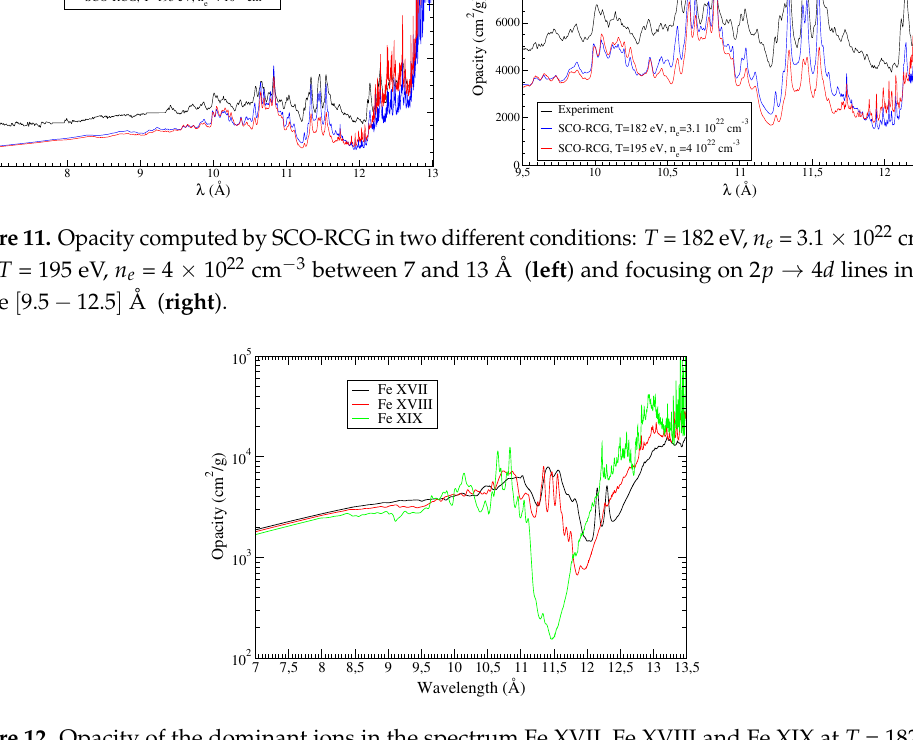
Figure 12. Opacity of the dominant ions in the spectrum Fe XVII, Fe XVIII and Fe XIX at T = 182 eV and n e = 3.1 × 10 22 cm − 3 ( ≈ 0.17 g/cm 3 ) computed by SCO-RCG. The opacity of each charge state is not weighted by the ionic